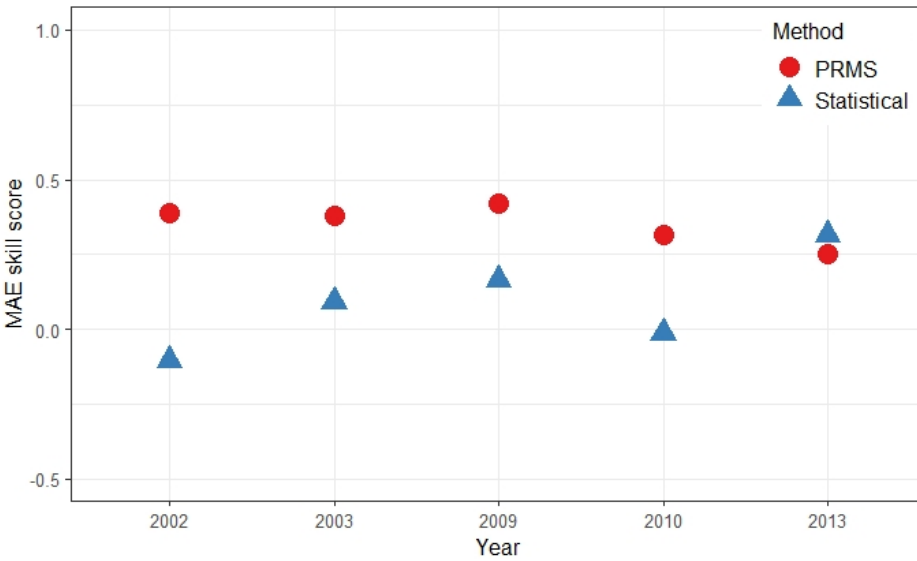
Figure 7. Comparison of the MAE skill score of the two forecasting methods.